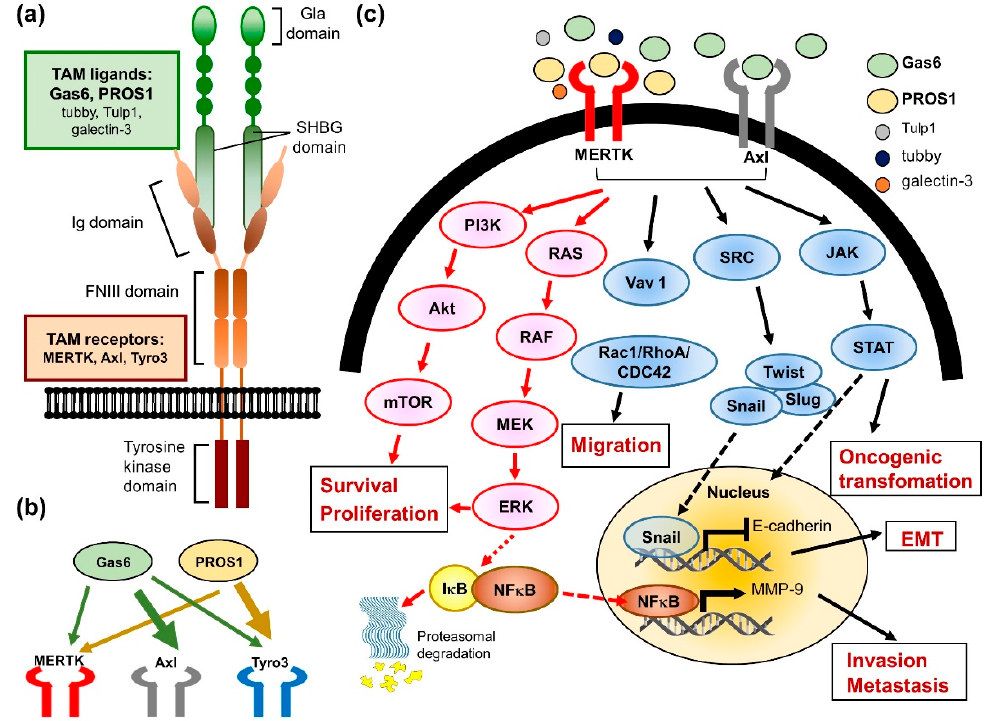
Figure 3. The biological role of MERTK in cancer cells. ( a ) The illustration of MERTK structure. ( b ) A model depicts the interaction of Tyro3-Axl-MERTK (TAM) receptors with their ligands (Gas6 and PROS1). The thickness of the arrows reflects the activation strength of each ligand to the TAM receptors. ( c ) Binding of ligands to the TAM receptors activates the downstream signaling pathways involving in cancer progression and drug resistance.